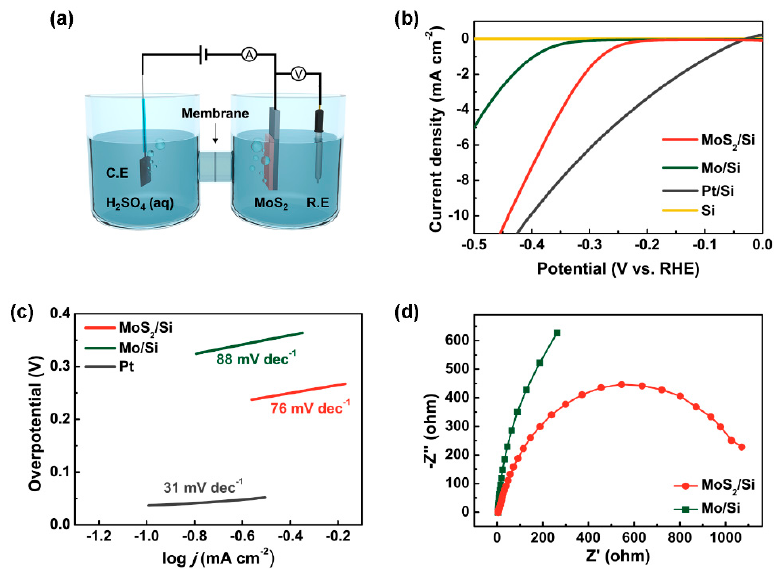
Figure 4. ( a ) Schematic of the hydrogen evolution reaction (HER) system. ( b ) Polarization curves of Si, Pt, Mo, and MoS 2 in the 0.5 M H 2 SO 4 electrolyte. The scan rate was 5 mV s − 1 , and the scan region was 0 to − 0.5 V vs. reversible hydrogen electrode (RHE). ( c ) Corresponding Tafel plots obtained from the polarization curves. ( d ) Nyquist plots for Mo and MoS 2 ; the applied potential was − 0.2 V vs. RHE.